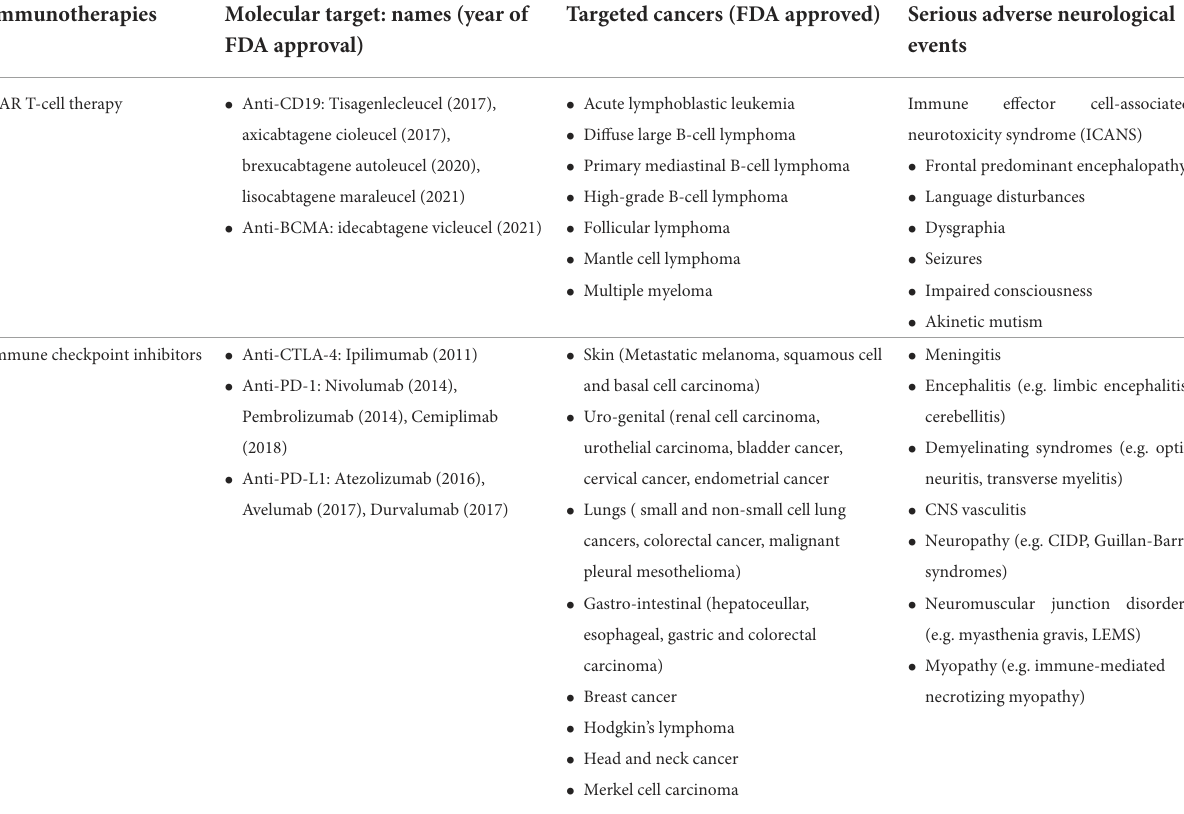
TABLE 1 Molecular mechanisms, targeted cancers and neurological syndromes of different immunotherapies * .